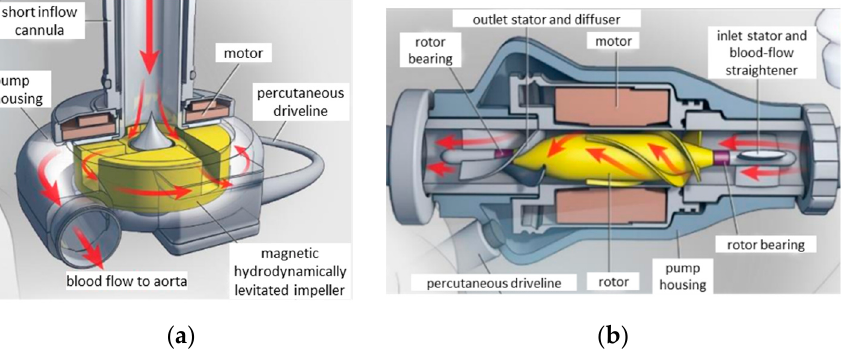
Figure 3. Pump types for LVAD and TAH applications; ( a ) centrifugal flow with a magnetic bearing for impeller suspension; and ( b ) axial flow with a conventional bearing. Republished with permission of Massachusetts Medical Society.